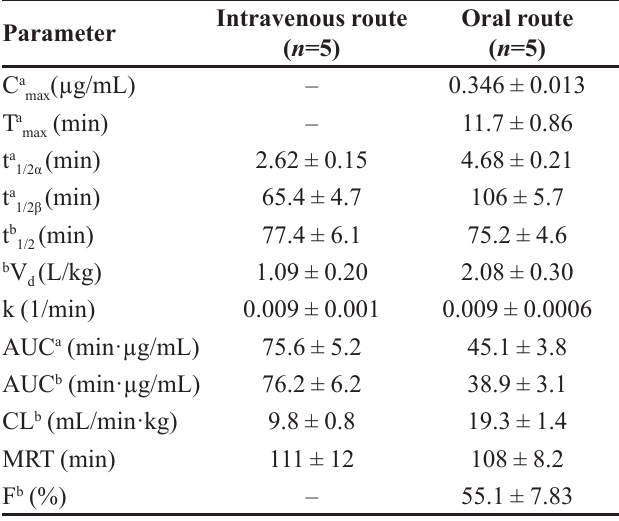
TABLE II - Pharmacokinetic parameters of oleracimine in rat (mean ± S.D., n = 5) following oral and intravenous routes of administration at dose of 2.5 mg/kg Parameter